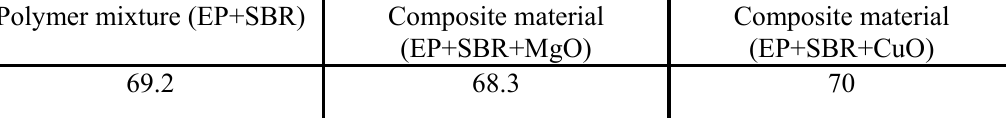
Table 3: Effect of nano fillers on the hardness